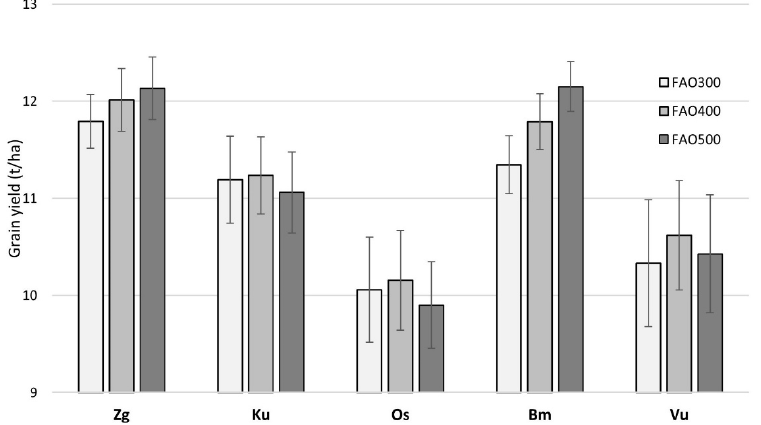
Figure 3. Unadjusted means for grain yield with corresponding standard errors in VCU trials across five locations in maize genotypes belonging to three maturity groups FAO 300, FAO 400, and FAO 500.